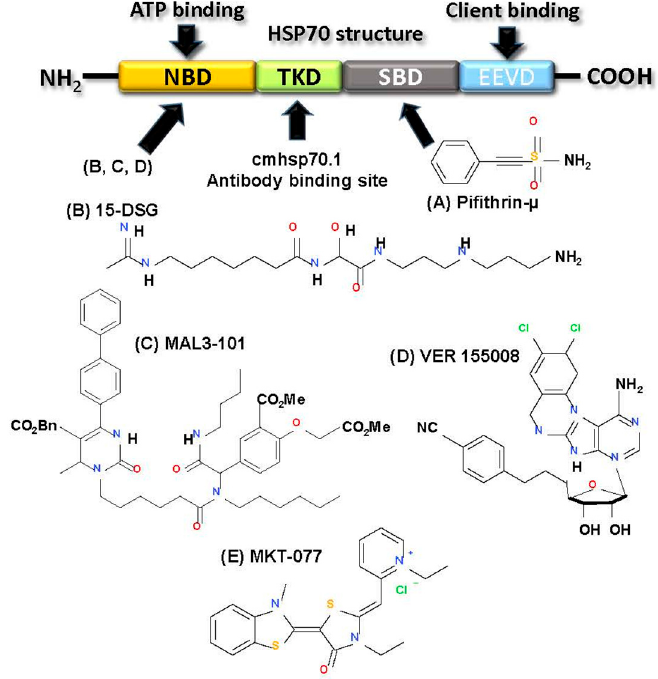
Figure 8. HSP70 targeting in cancer. HSP70 consists of two major domains—the nucleotide binding domain (NBD) and the C-terminal peptide binding domain (PBD). PBD contains the domain (NBD) and the C-terminal peptide binding domain (PBD). PBD contains the substrate binding domain (SBD), TKD and a carboxyl-terminal chaperone EEVD motif. ( A ) The aptamer A17